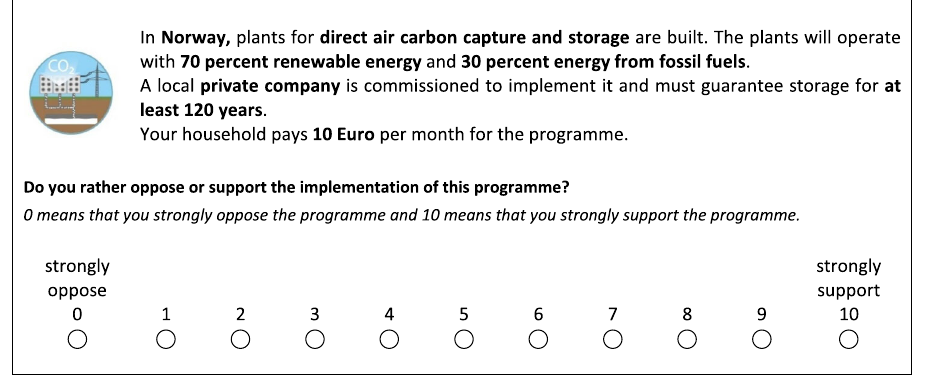
Fig. 2 Respondents saw 3 vignettes for Direct Air Capture (DACCS). The parts of the explanation printed in bold took different levels as presented in Table